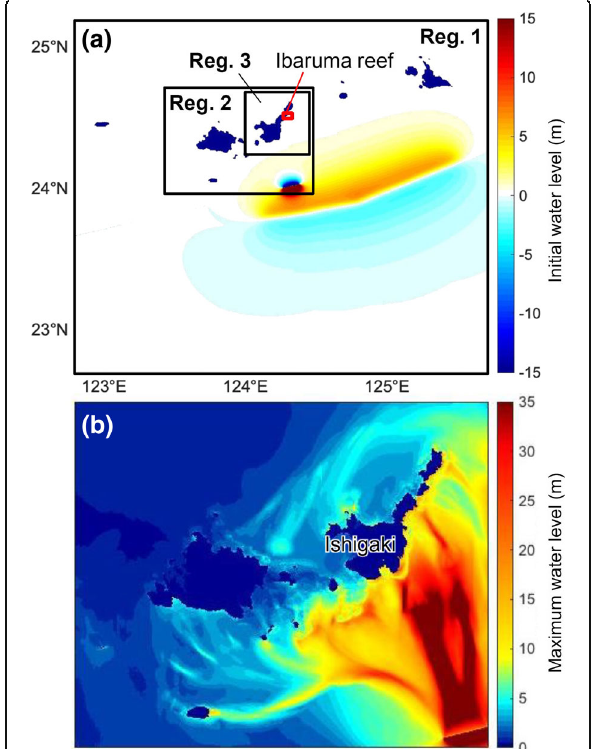
Fig. 3 a Computational domains for this study from region 1 to region 3. The initial water level of the 1771 Meiwa tsunami is also shown after Miyazawa et al. (2012) and Hisamatsu et al. (2014). b Maximum water level at 45 min after the tsunami in region 2 calculated in this study